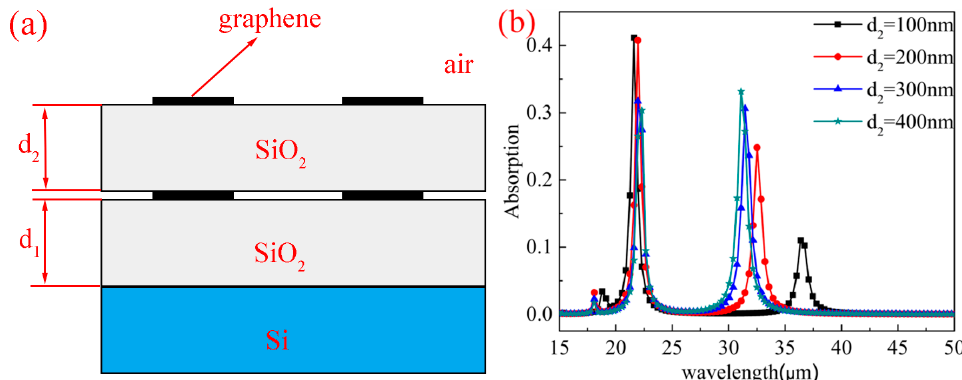
Figure 8. ( a ) The side view of the structure consisting of bilayer graphene arrays covered with two thin SiO 2 layers with thickness d 1 and d 2 . ( b ) The absorption spectra of the structure with di ff erent d 2 values.